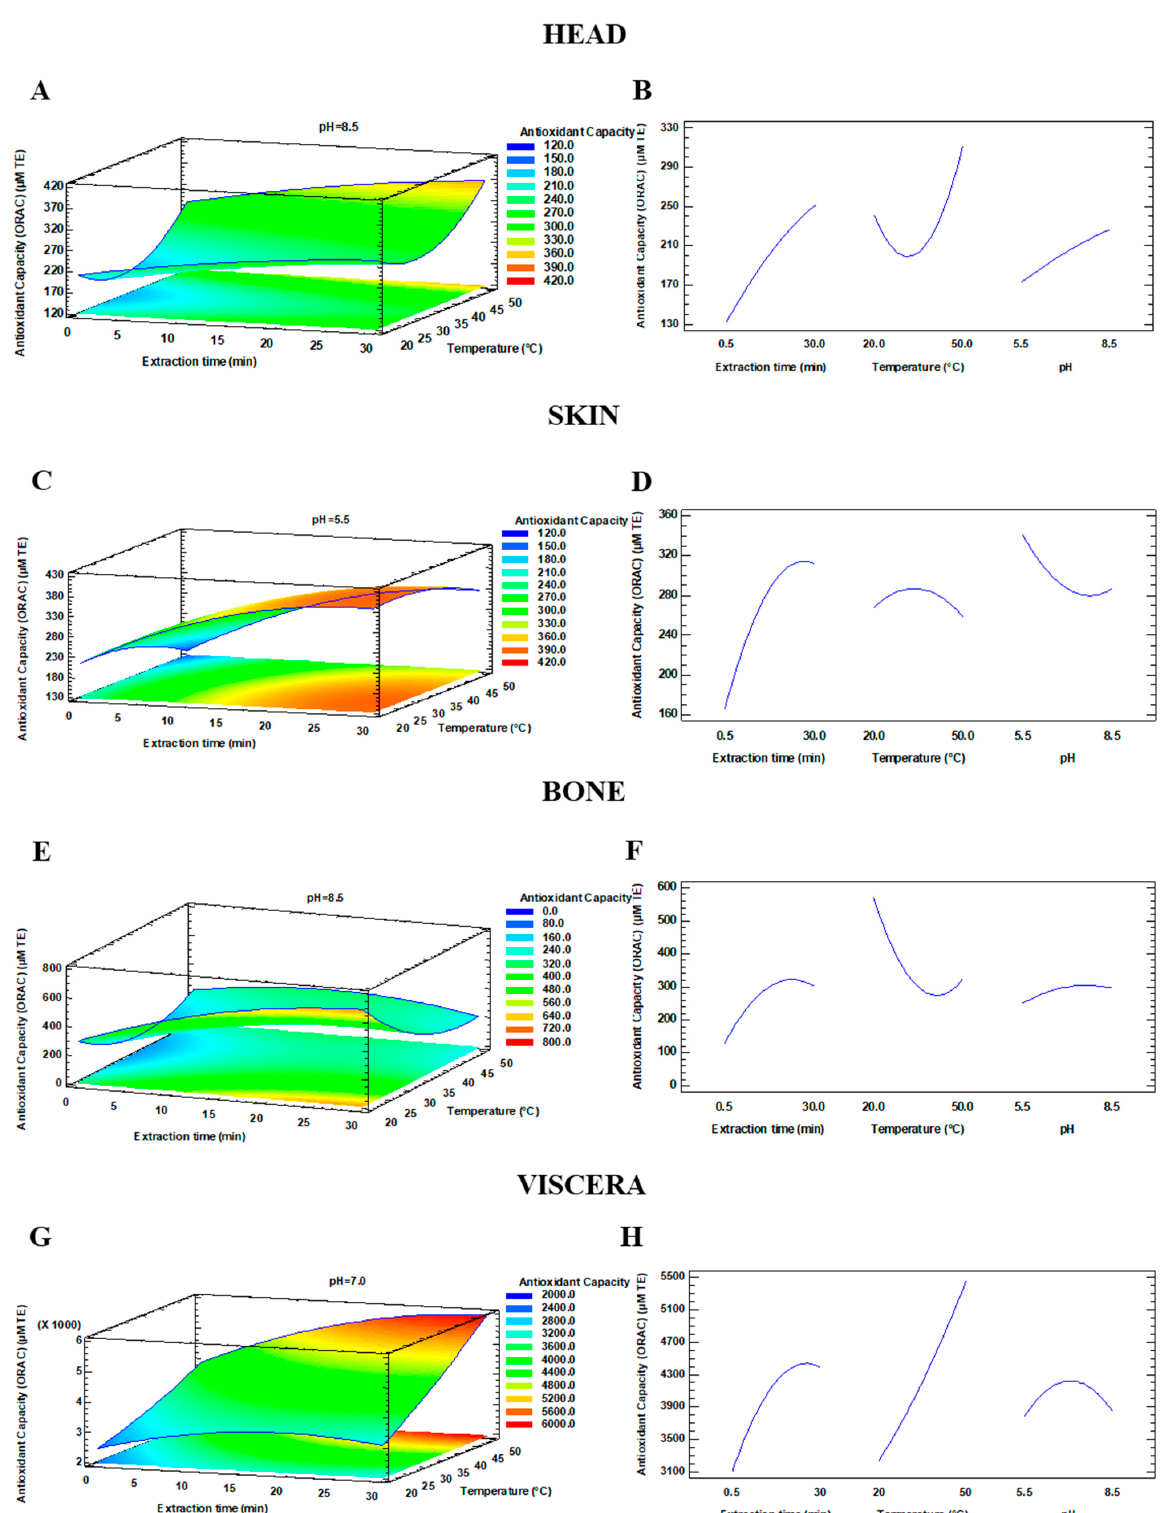
Figure 4. Plots shown in ( A , C , E , G ) indicate the response surface plots for the percentage of antioxidant capacity as a function of the extraction time (min) and temperature ( ◦ C) at a constant pH. The plots in ( B , D , F , H ) represent the plot of the influence of the different studied parameters on the antioxidant capacity values determined as µ M TE (Trolox equivalent) using the ORAC